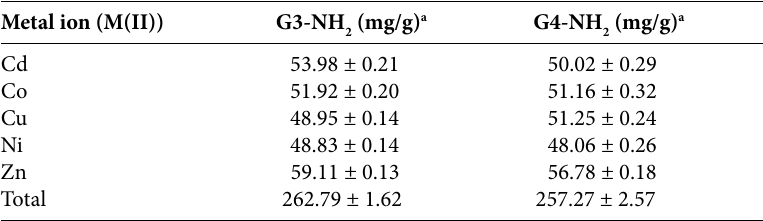
Table 5. Metal ion uptake and binding properties of different generation (G3-G4) JCPDS under competitive conditions at pH